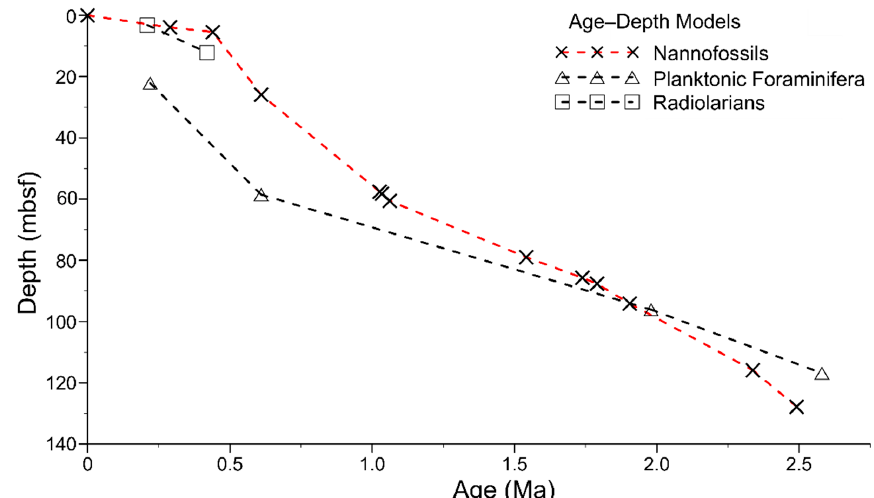
Figure 12. Comparison of age–depth models using different microfossil groups for Site U1431D. Symbols represent specific microfossil groups found in the site. The nannofossil age model